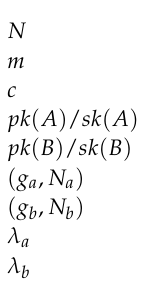
algorithm with additive homomorphism and GM encryption algorithm with Xor